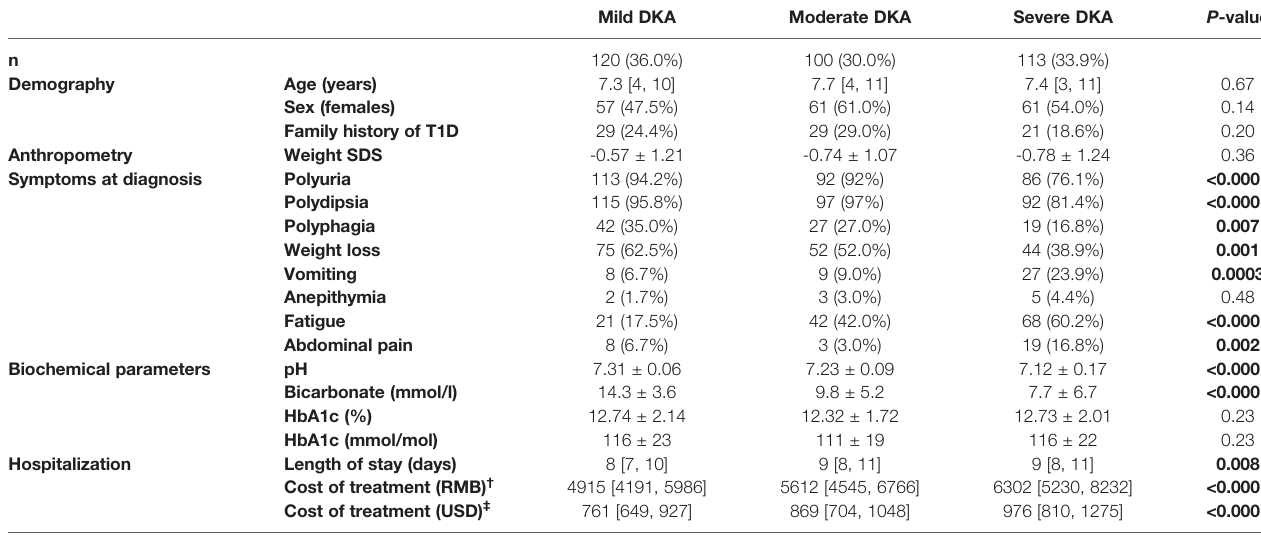
TABLE 2 | Demographic and clinical data at type 1 diabetes (T1D) diagnosis in children and adolescents at the Children ’ s Hospital of Zhejiang University School of Medicine (Hangzhou, China), according to diabetic ketoacidosis (DKA) severity. Mild